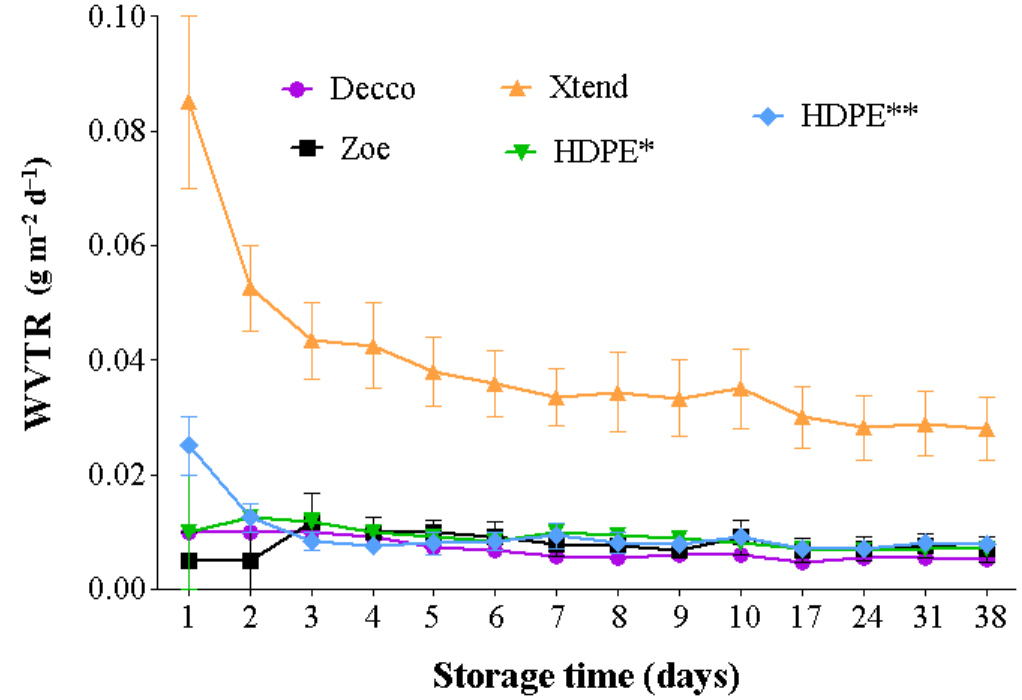
Figure 3. Water vapor transmission rate across plastic liner walls under a controlled environment of 20 °C and 65% relative humidity (RH). The non-perforated film section of the 2 mm HDPE (*) and 4 mm HDPE (**) liners were used. HDPE: high density polyethylene.